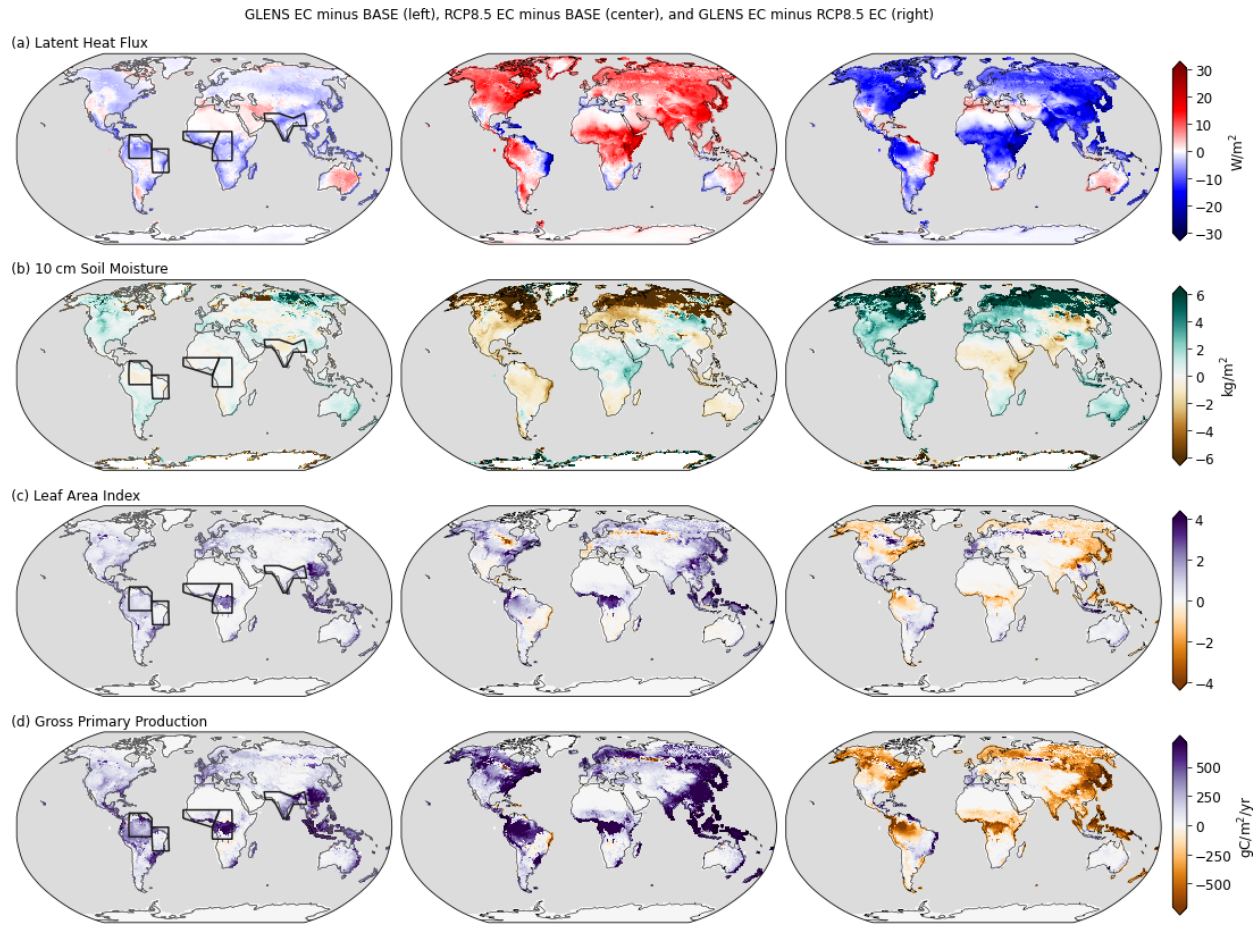
Figure 10. Projected changes between GLENS EC (2075–2095) and BASE (2010–2030) in the left column, changes between RCP8.5 EC (2075–2095) and BASE (2010–2030) in the center column, and changes between GLENS EC (2075–2095) and RCP8.5 EC (2075–2095) in the right column for (a) latent heat flux, (b) soil moisture in the top 10cm, (c) total leaf area index, and (d) gross primary production. Black polygons in the left column highlight the following regions: northeastern South America (NSA), northern South America, western Africa (WAF), central Africa (CAF), and South Asia